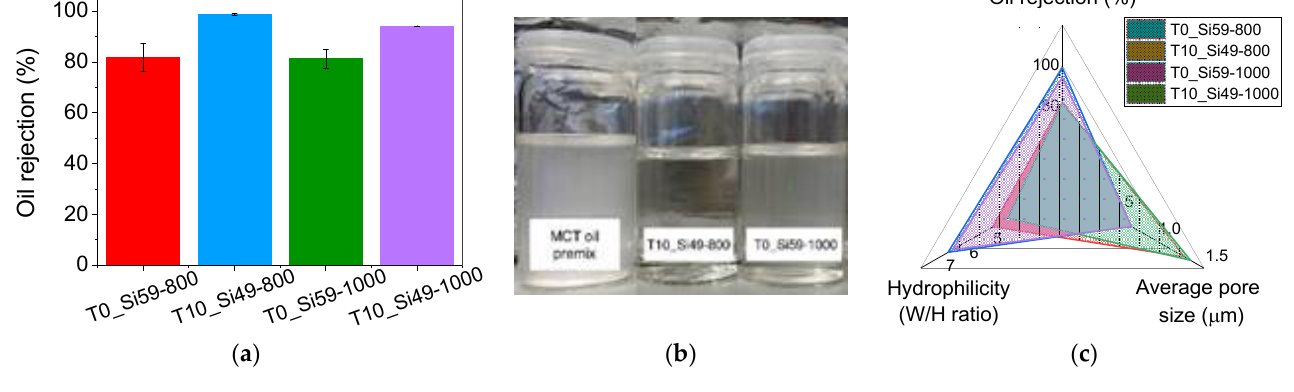
Figure 10. ( a ) MCT oil rejection for samples T0_Si59-800, T10_Si49-800, T0_Si59-1000 and T10_Si49- 1000. ( b ) MCT oil emulsion before and after filtration with membranes T10_Si49-8000 and T0_Si59- 1000. ( c ) Radar plot with the different parameters influencing the oil rejection.